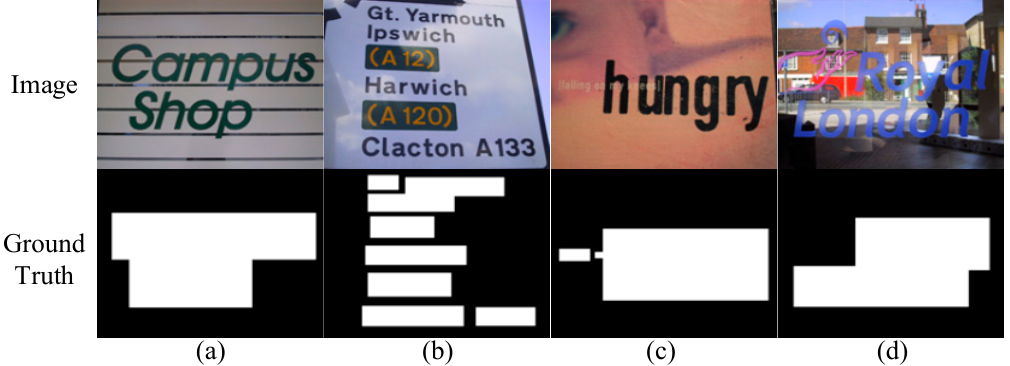
Figure 8. Several examples of difficulties in text detection in the ICDAR2013 dataset. ( a ) Background destruction font structure. ( b ) Perspective transformation and uneven illumination. ( c ) Text is too small and low contrast. ( d ) Complex background and low contrast.